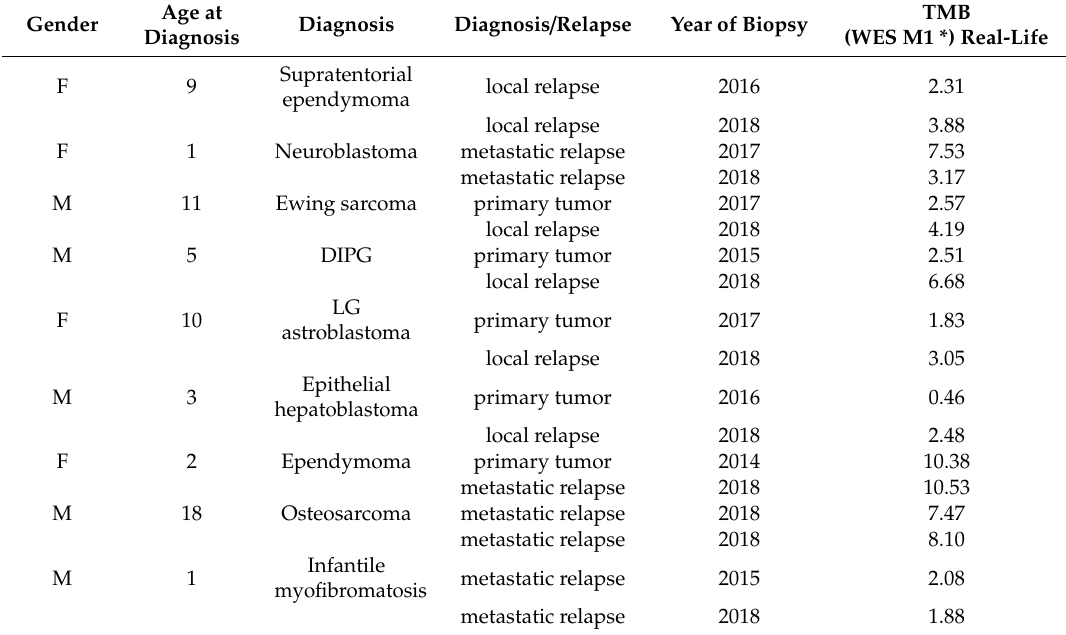
Table 3. WES-based TMB values during tumor progression in nine patient case